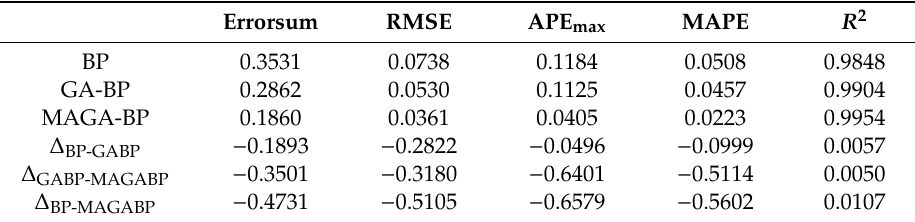
Table 11. Performance evaluation of three prediction models.